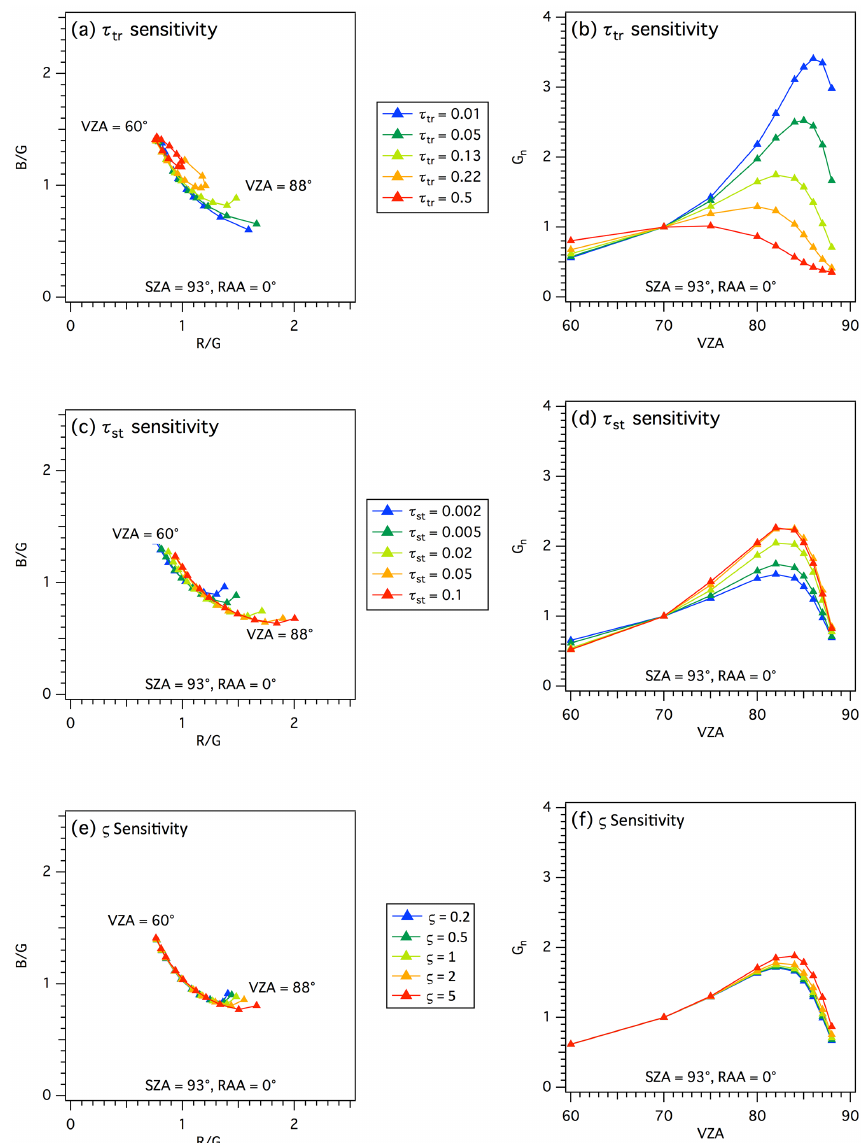
Figure 4. Sensitivity test results for normalized brightness ( G n ) and color ratios (B / G, R / G) of twilight sky: (a, b) sensitivities to tropo- spheric aerosol optical thickness; (c ,d) sensitivity to stratospheric aerosol optical thickness; (e, f) sensitivity to coarse–fine particle volume ratio. Panels on the right side (b, d, f) show the dependence of normalized brightness variations along with the viewing zenith angles. Panels on the left side (a, c, e) show the dependence of color ratio variations along with the viewing zenith angles on R / G–B / G cross sections. The SZA and RAA are 93 and 0 ◦ ,